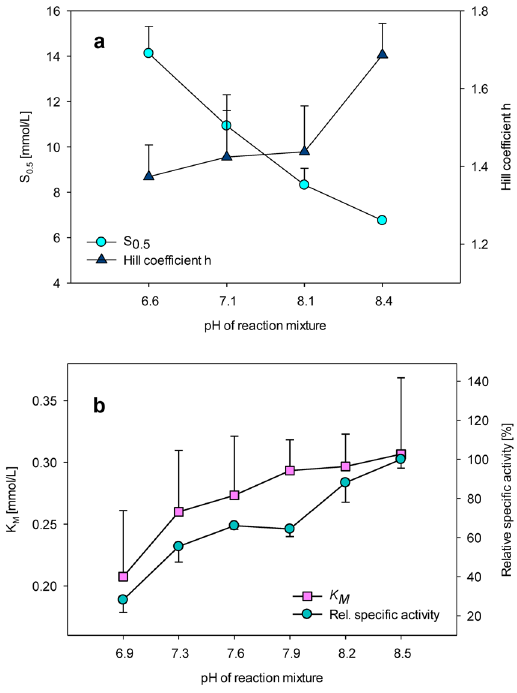
Figure 2. The effects of the pH on enzyme kinetics of human GCK and HK2. ( a ) S 0 . 5 and the Hill index ( h ) of human GCK as measured in the pH range from 6.6 to 8.4. ( b ) K M and relative specific activity of human HK2 as measured in the pH range from 6.9 to